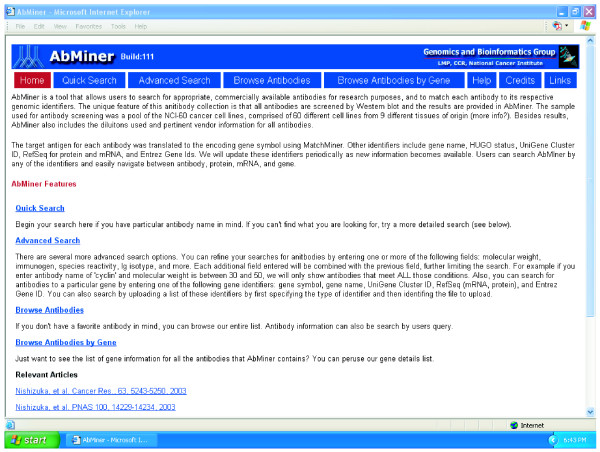
Screen shot of the AbMiner home page, at . All search and browse links are shown, along with brief descriptions of each function. [Note to the Editor and Reviewers: The screen shot will be updated to reflect its content at the time of publication.]